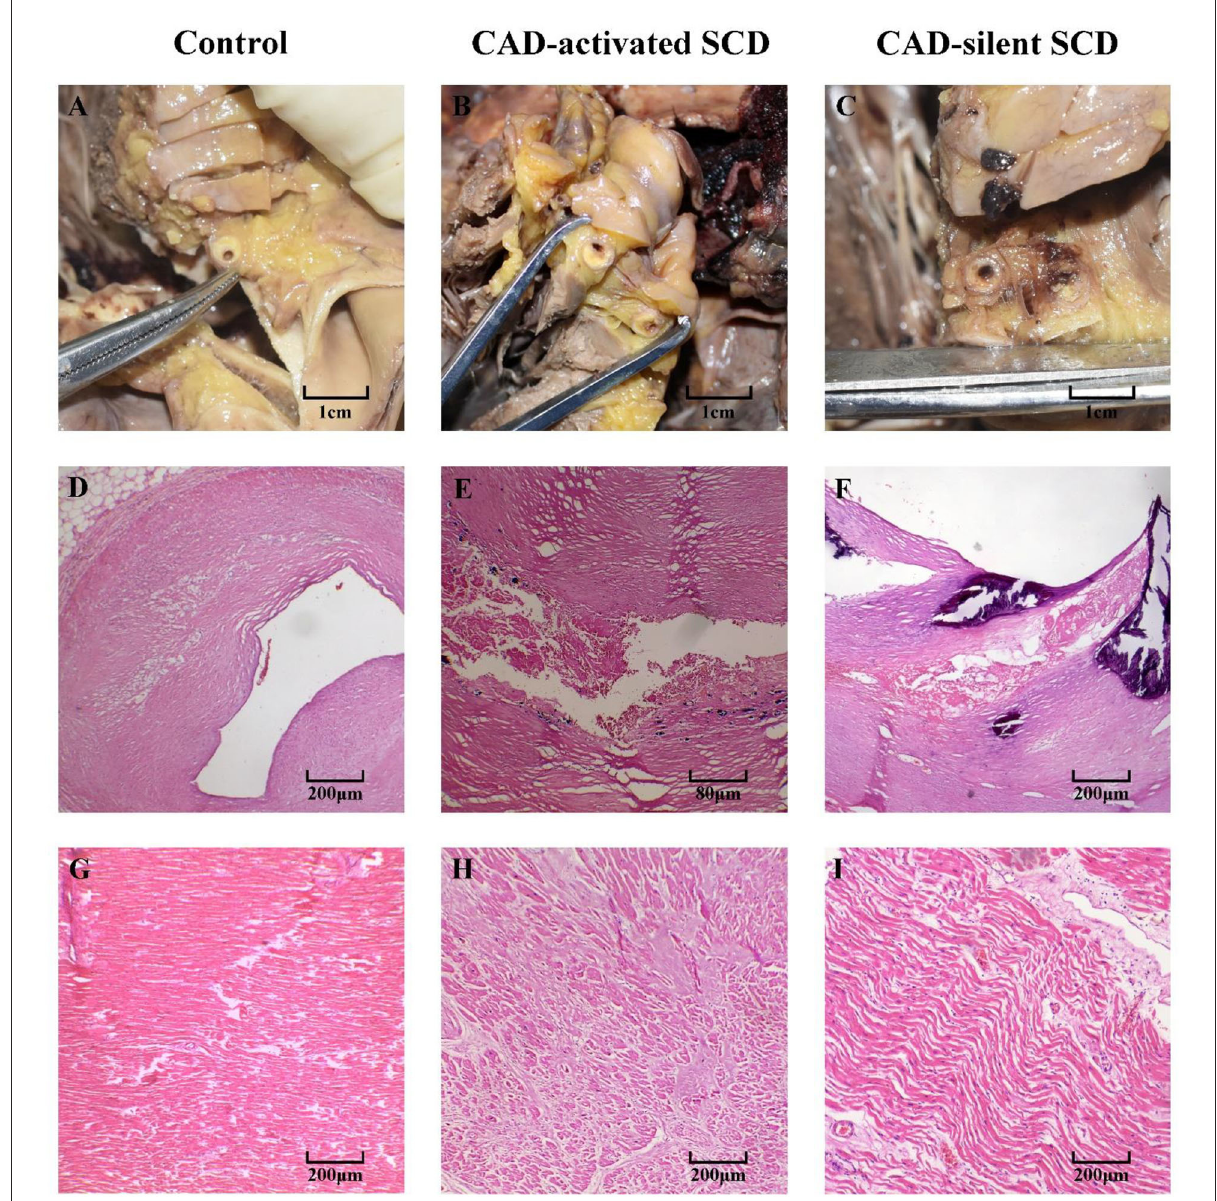
FIGURE1 The cardiac pathological changes of CAD-activated SCD, CAD-silent SCD, and control. (A–C) Gross investigation of coronary arteries: atherosclerotic plaques caused significant luminal stenosis. Stable plaques were found in the control group (D) . CAD-activated SCD and CAD-silent SCD victims presented with unstable plaques, including rupture and hemorrhage (E,F) . Myocardial tissues of control subjects were basically normal, with mild interstitial expansion (G) . Myocardial hypertrophy and dense fibrotic scar were found in CAD-activated SCD victims (H) . Just slight pathological changes, including interstitial edema, wavy changes of cardiomyocytes, and inflammatory cell infiltration, were identified in CAD-silent SCD victims (I) .